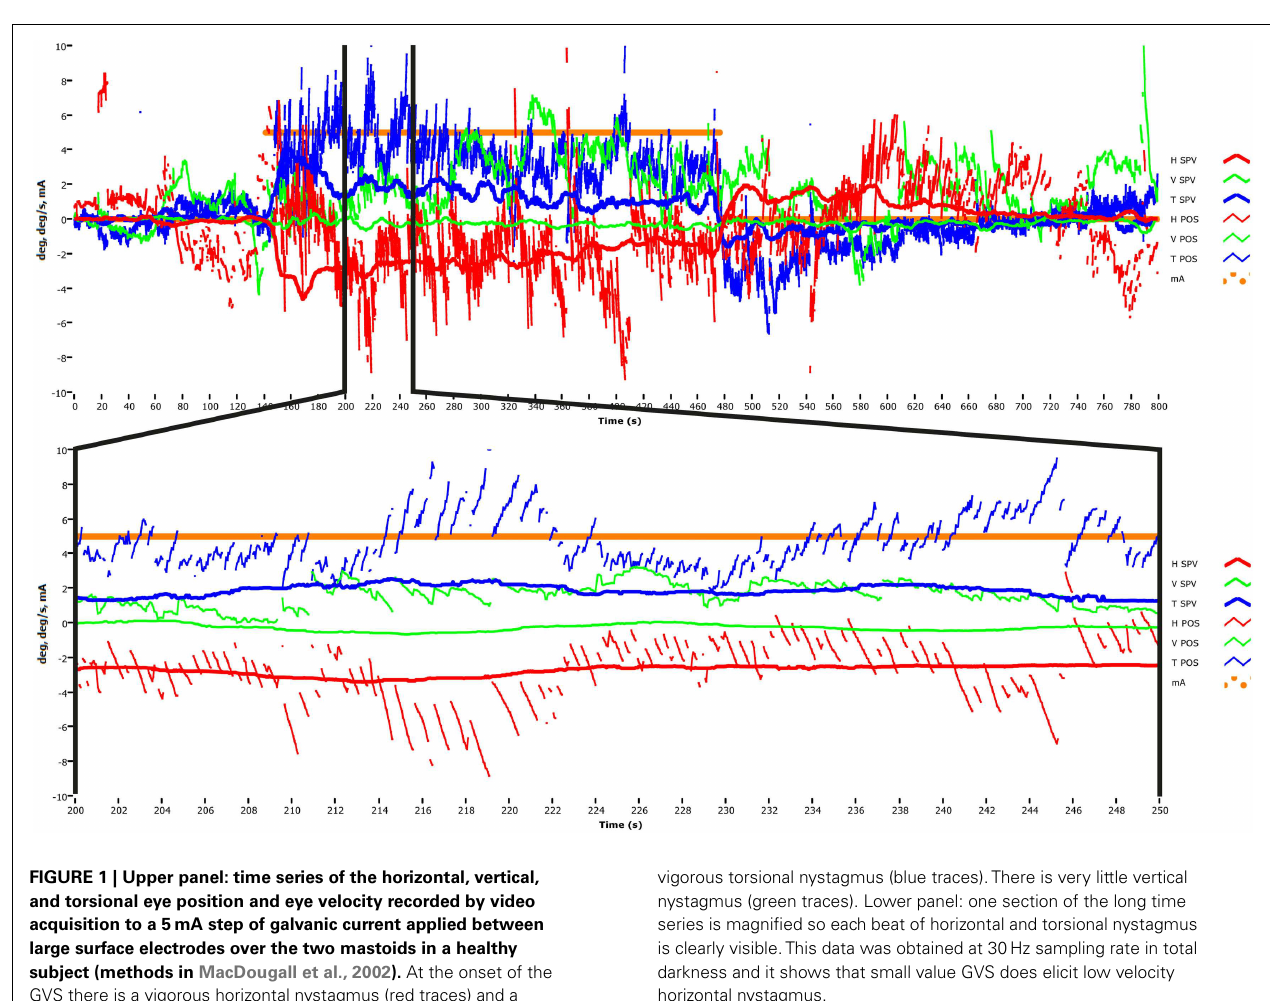
FIGURE 1 | Upper panel: time series of the horizontal, vertical, and torsional eye position and eye velocity recorded by video acquisition to a 5mA step of galvanic current applied between large surface electrodes over the two mastoids in a healthy subject (methods in MacDougall et al., 2002). At the onset of the GVS there is a vigorous horizontal nystagmus (red traces) and a